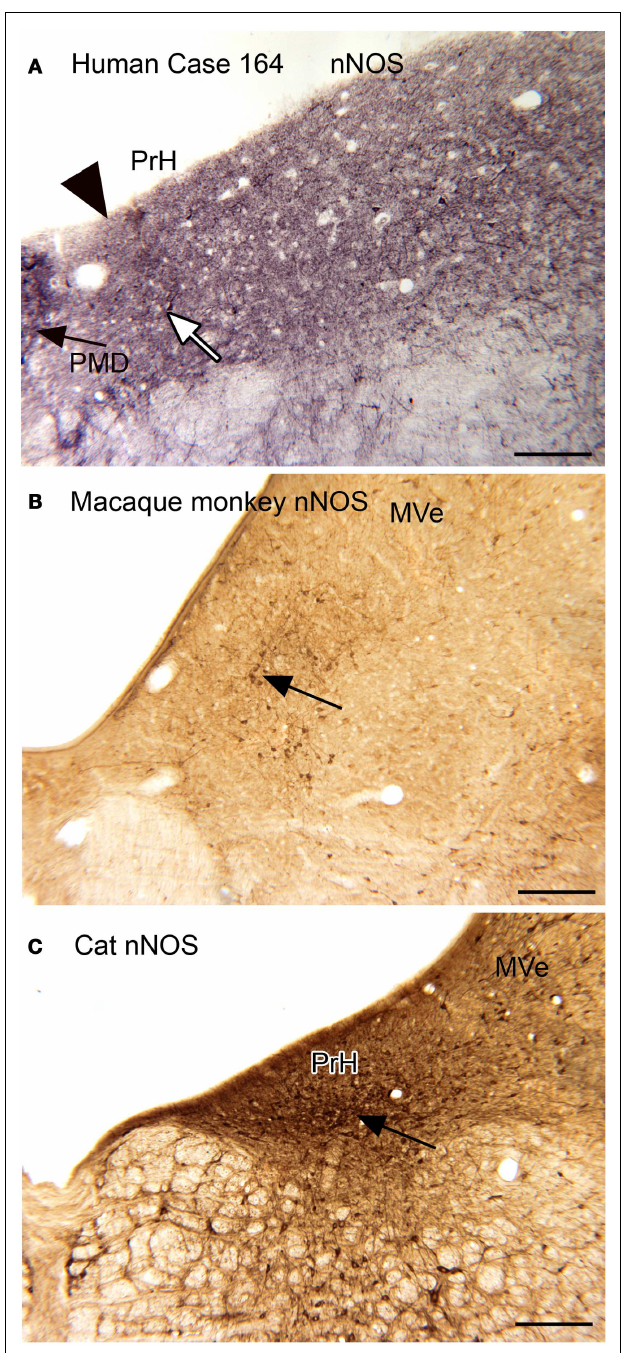
FIGURE 3 | (A) nNOS-ir in the nucleus prepositus hypoglossi (PrH) in the human, Case 164, female, age 45.There is diffuse punctate label and a few stained neurons.The white arrow indicates one of a few stained cells.The arrowhead marks the medial border of PrH.The black arrow shows the lateral edge of the nucleus paramedianus dorsalis. Glucose oxidase visualization. Scale bar 250 µ m. (B) nNOS-ir in PrH of macaque monkey; the arrow shows a cluster of labeled cells. Immunoreactivity visualized with DAB-H 2 O 2 . Scale bar 250 µ m. (C) nNOS-ir in PrH of the cat.The arrow shows the ventral cluster of labeled cells. Immunoreactivity visualized with DAB-H 2 O 2 . MVe, medial vestibular